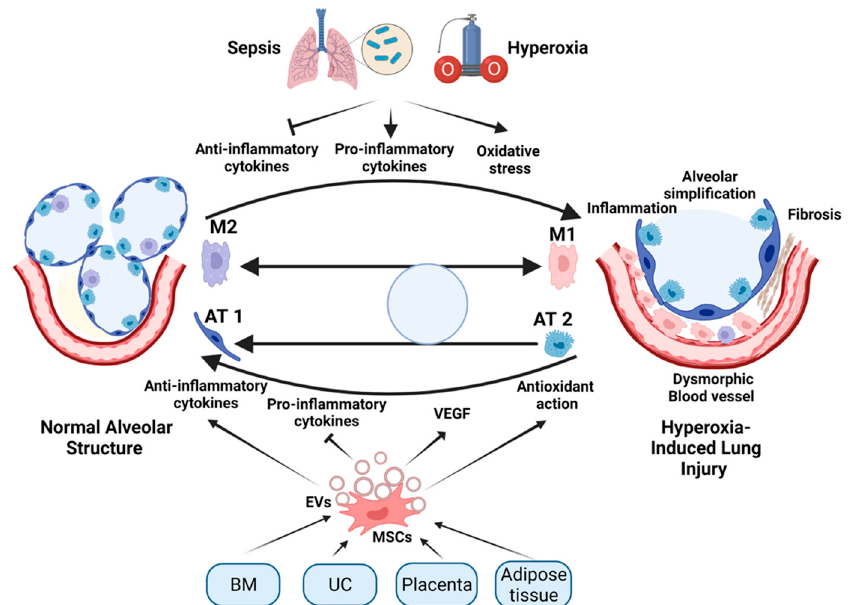
Figure 1. Schematic diagram illustration of the role of MSCs and secretion of their EVs in the treatment of hyperoxia-induced lung injury. As the preterm neonatal lung is exposed to excessive oxygen supplementation (hyperoxia) or infection (sepsis), proinflammatory cytokines are released, anti-inflammatory cytokines are inhibited, and oxidative stress occurs. These changes direct the conversion of M2 to M1 macrophage subsets, leading to structural lung damage/developmental abnormalities. MSCs are derived from various sources including bone marrow (BM), umbilical cord (UC), placenta, and adipose tissue. Treatment with MSCs or their secreted EVs alleviates the hyperoxia-induced lung injury through several mechanisms. These mechanisms include inhibition of proinflammatory cytokines and induction of anti-inflammatory cytokines, VEGF, and antioxidant pathways, leading to the transition of M1 to M2 macrophages, and the stimulation of differentiation of AT2 alveolar epithelial cells to AT1 alveolar epithelial cells. This illustration was created using BioRender.com.